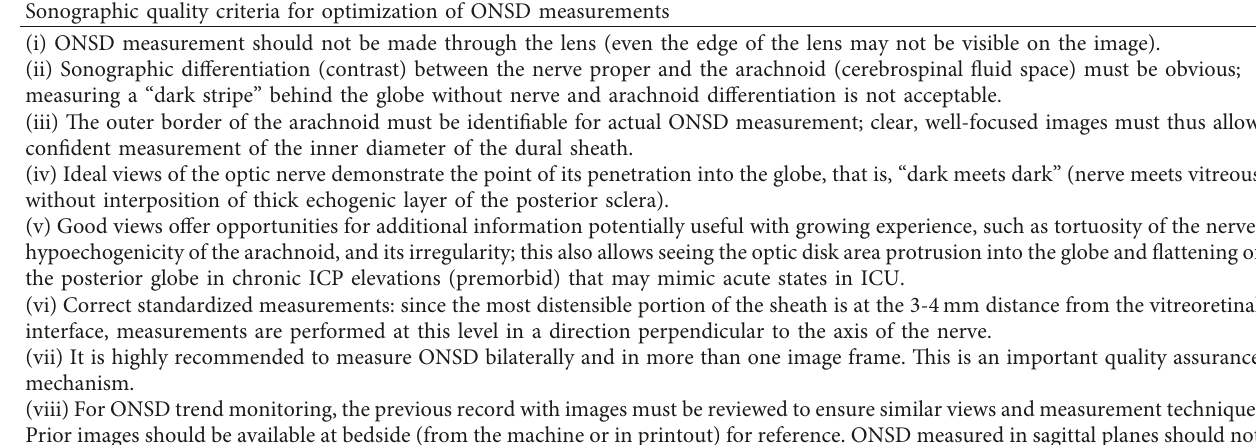
Table 1: Proposed sonographic quality criteria for optic nerve sheath diameter (ONSD) measurements (adapted from Sargsyan et al. [21]). Sonographic quality criteria for optimization of ONSD measurements